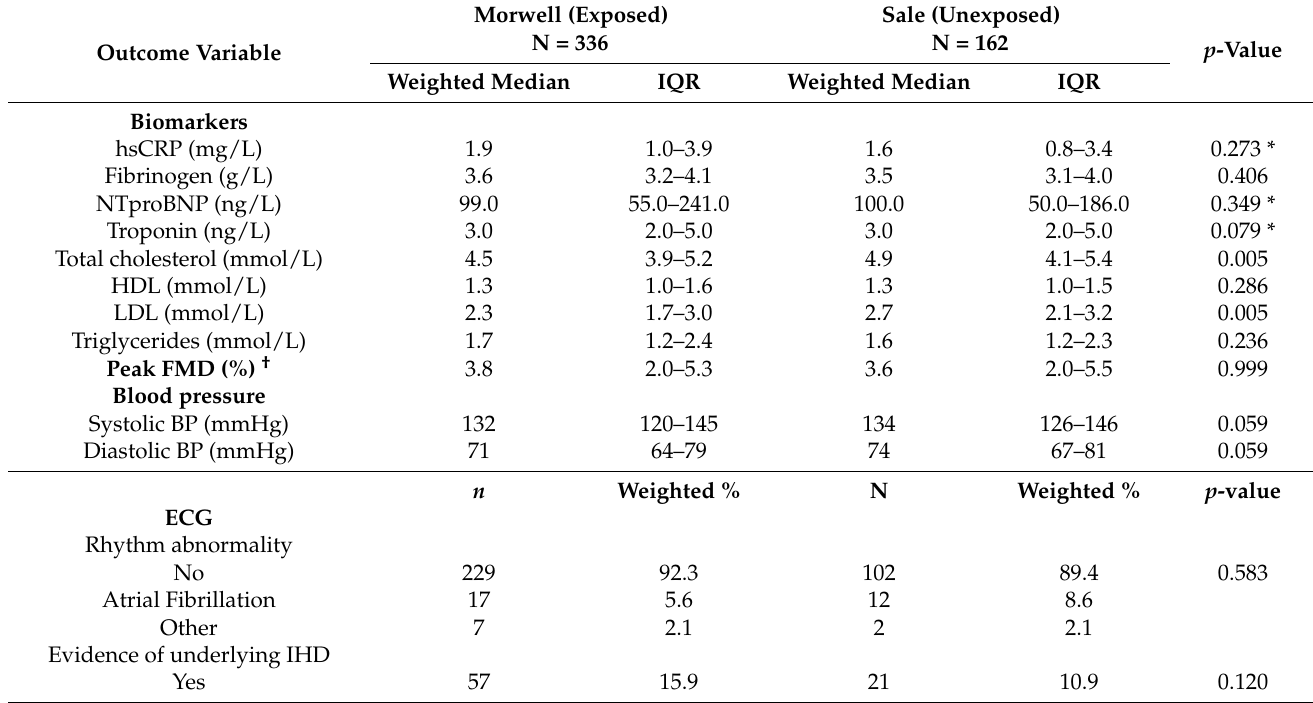
Table 3. Cardiovascular outcomes for participants from Sale and Morwell.